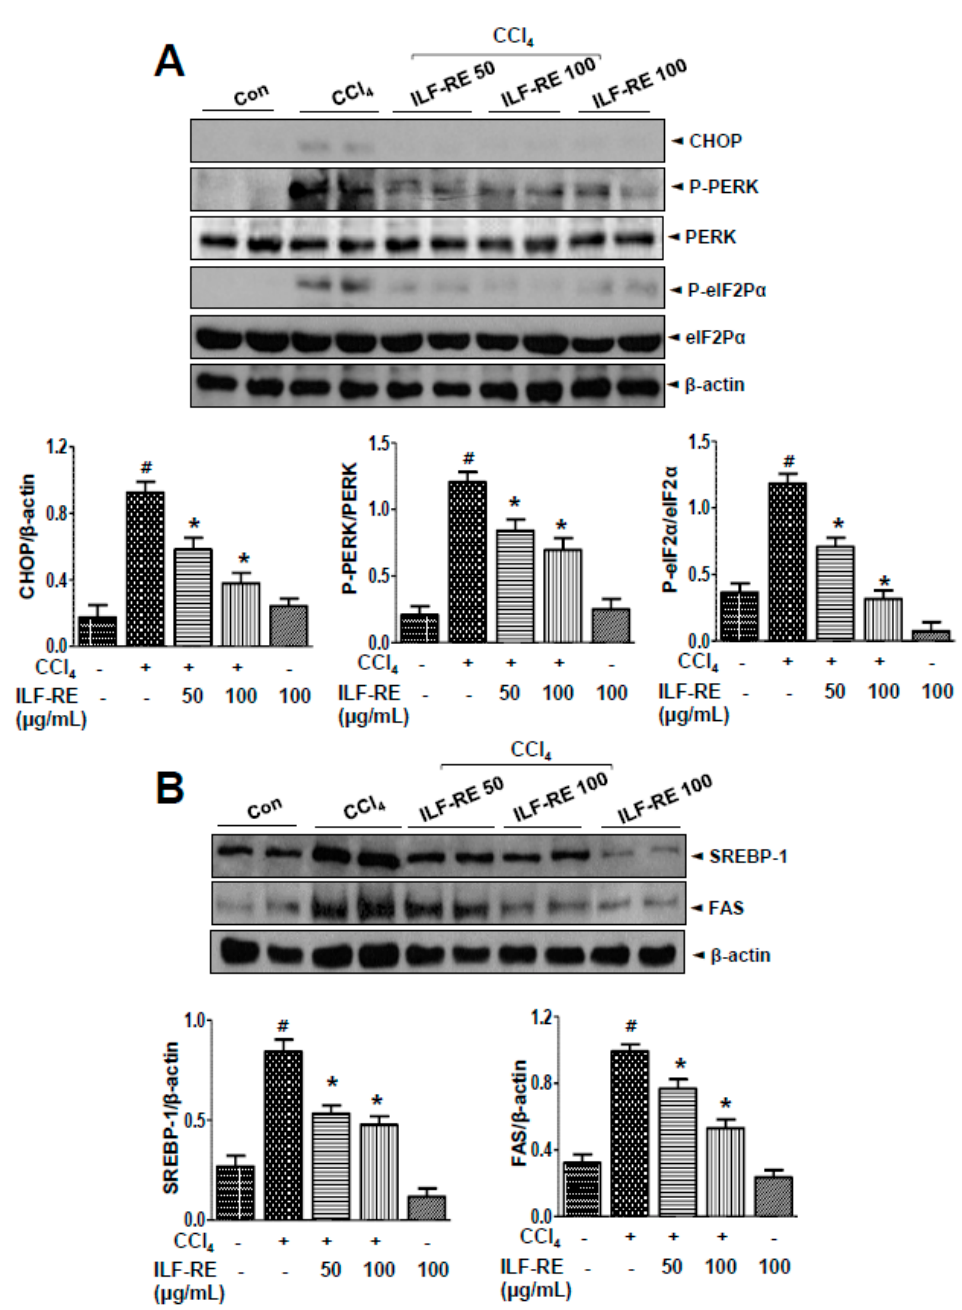
Figure 7. ILF-RE inhibits CCl 4 -induced ER stress and lipogenesis. Primary hepatocytes were treated with 20 mM CCl 4 in the absence or presence of 50 and 100 µ g/mL ILF-RE for 6 h. ( A ) Immunoblotting was performed using anti-CHOP, anti-p-PERK, anti-PERK, anti-p-eIF2 α , anti-eIF2 α , or anti- β -actin antibodies. Quantification of immunoblot data was performed (lower panel). ( B ) Immunoblotting was performed using anti-SREBP-1, anti-FAS, and anti- β -actin antibodies. Quantification of immunoblot data was performed (lower panel). Data are expressed relative to the controls ( n = 3; # p < 0.05 vs. Con; * p < 0.05 vs. CCl 4 ). Con, control; CCl 4 , carbon tetrachloride; ILF-RE, the combination R. verniciflua with E. ulmoides ; ER, endoplasmic reticulum.